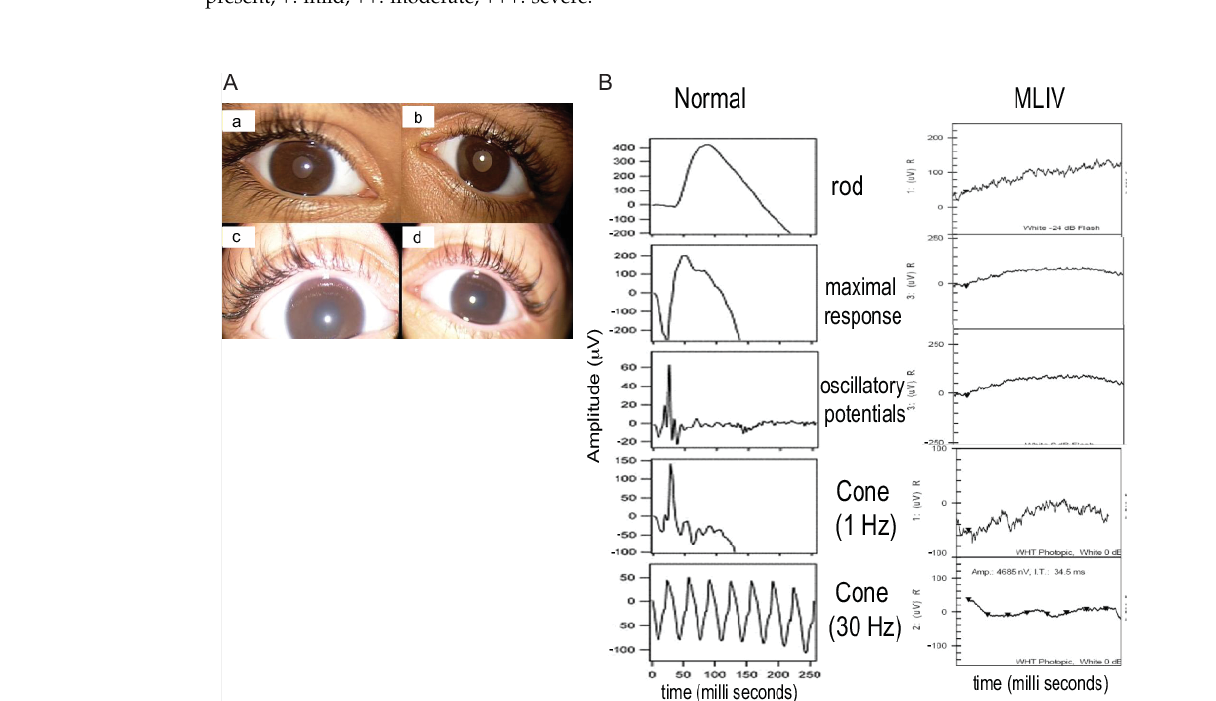
Figure 2. Ophthalmological findings in patients with mucolipidosis type IV (MLIV). ( A ): Anterior segment pictures showing mild corneal haze in the right ( a ) and left eye ( b ) in the 9 ‐ year ‐ old patient of Family 2 (patient #5). Severe corneal haze in the right ( c ) and left ( d ) eyes of the 2 ‐ year ‐ old patient of Family 2 (patient #6). ( B ): Full ‐ field electroretinography (ERG) was performed using the LKC machine, according to the International Society for Clinical Electrophysiology of Vision (ISCEV) protocol. The electroretinogram of patient #6 of Family 2 is shown. All rod and cone response curves were flattened in the MLIV patient (right) compared to those obtained from a normal subject (left). The electroretinograms of other patients (1,3,4,5) were also severely reduced.